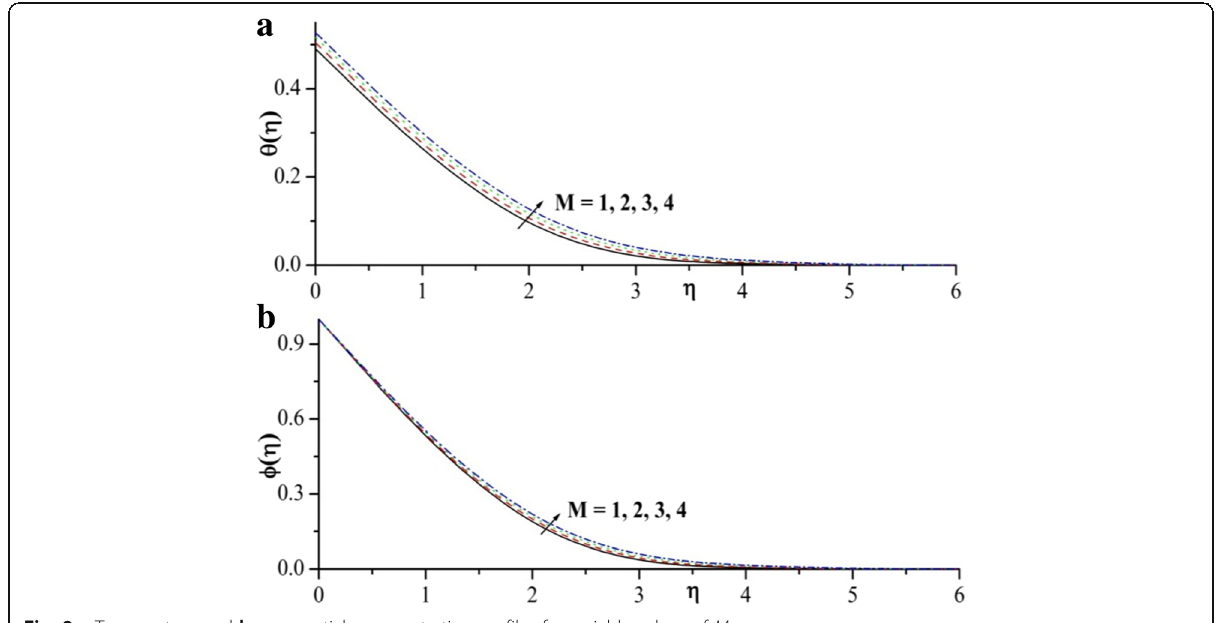
Fig. 9 a Temperature and b nanoparticle concentration profiles for variable values of